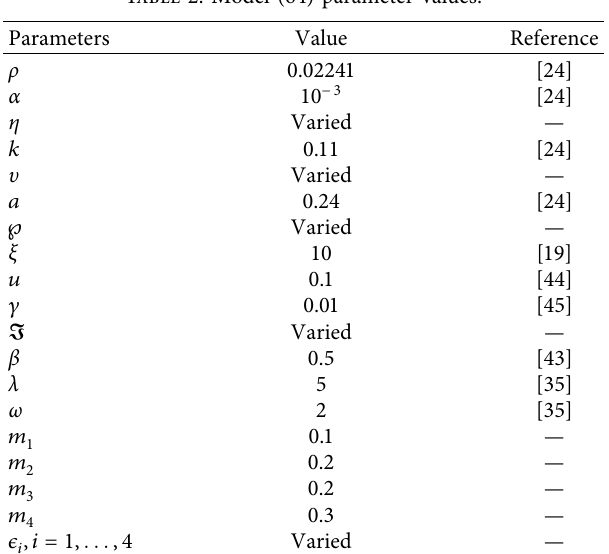
Table 2: Model (64) parameter